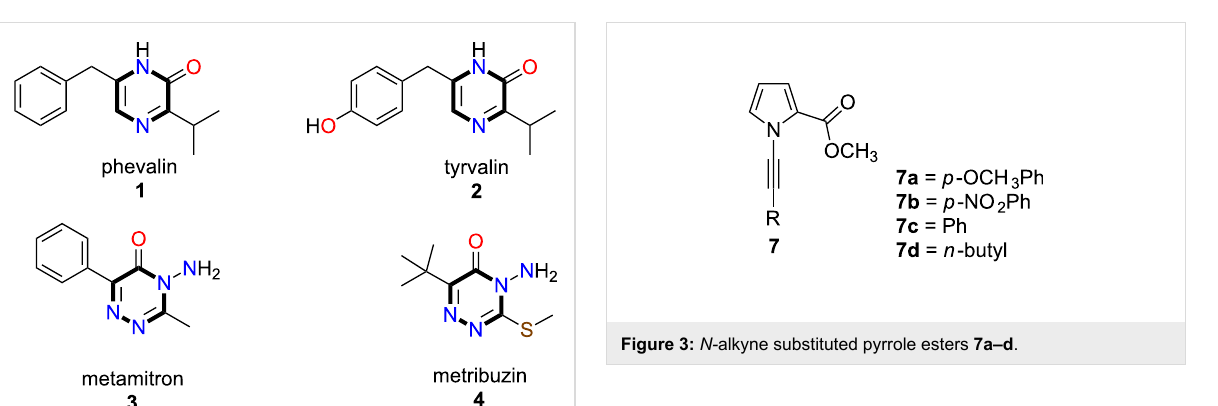
1,2,4-triazinone herbicides having an amino group, are absorbed by the roots of plants and inhibit photosynthesis by inhibiting electron transport (Figure 1). They are used to control grasses pre- and post-emergence [9,10].